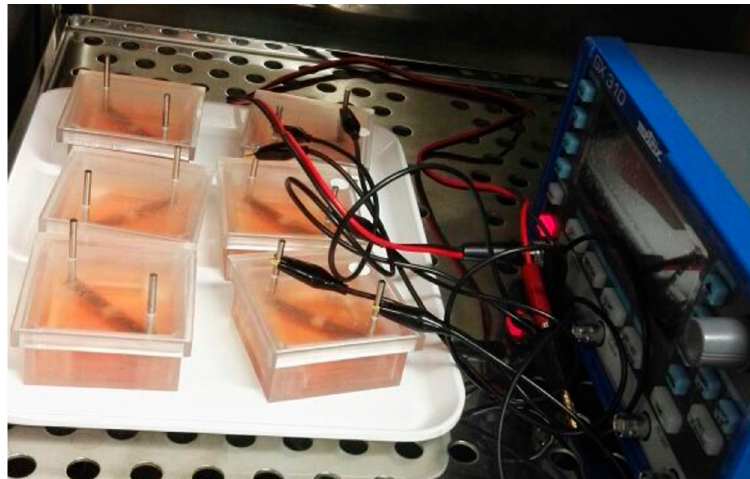
Figure 1. Experimental setup showing stimulated and non-stimulated adipose-derived stem cells seeded on coverslips with electrodes.